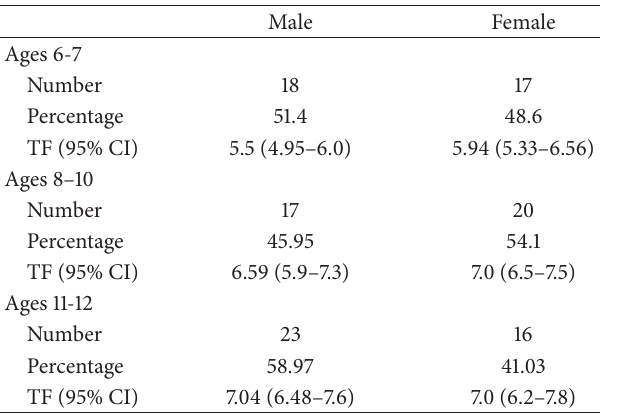
Table 1: Sample in number and percentage for groups of age and mean of dental fluorosis using TF index.